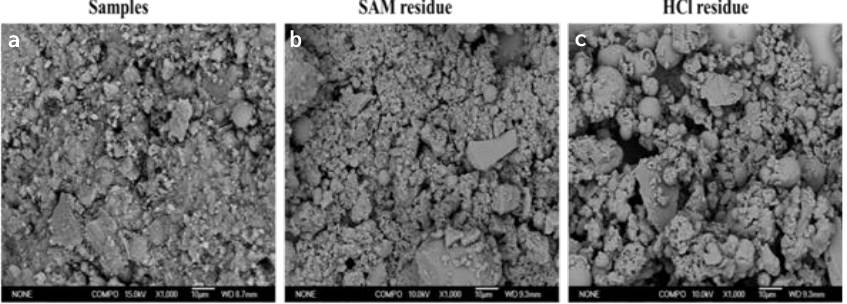
Figure 12. FTIR spectra of samples with different Ms at C-1 curing condition.